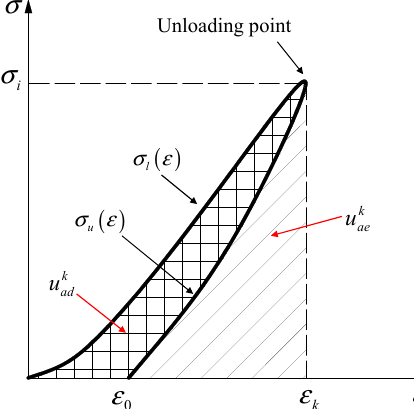
Figure 1. Calculation of elastic strain energy index.